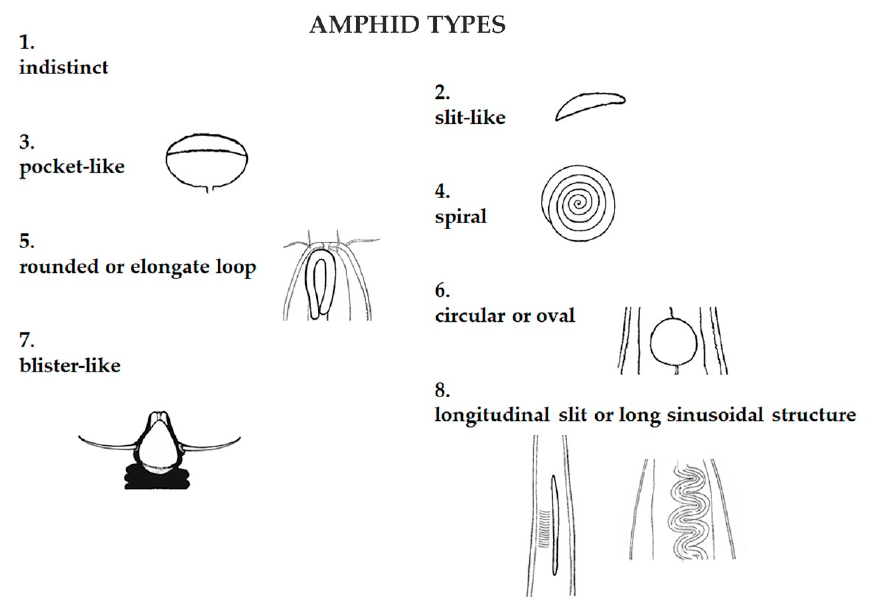
Figure 2. The amphids, chemosensory organs located in the head region of nematodes, play a role in the search for food and partners. Eight categories were identified on the base of the amphidal fovea shape.